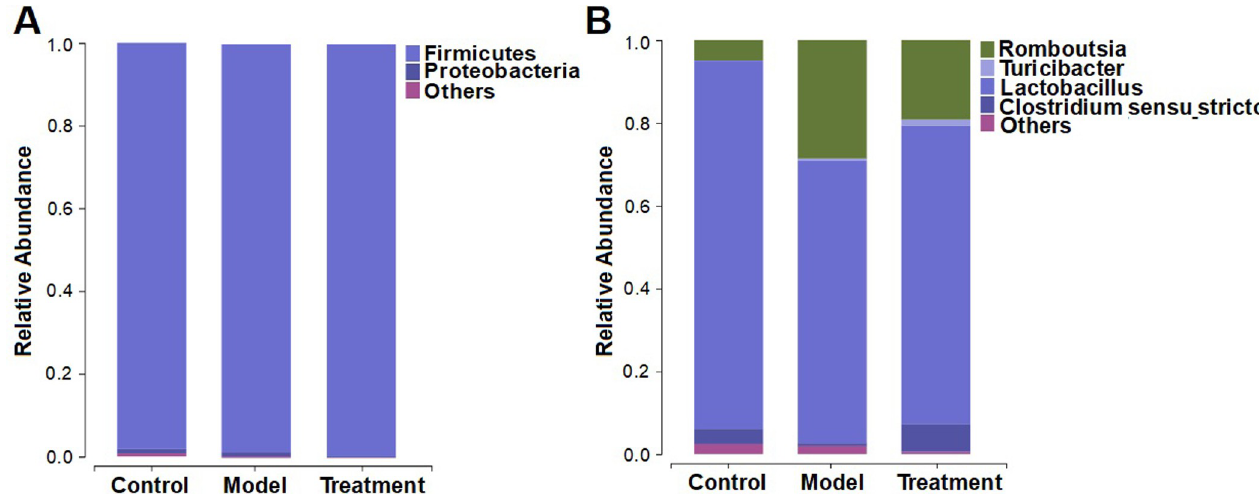
Fig 3. Influence of the MMWA treatment on gut microbiota composition. (A) Taxonomic composition at the phylum level. (B) Taxonomic composition at the genus level.